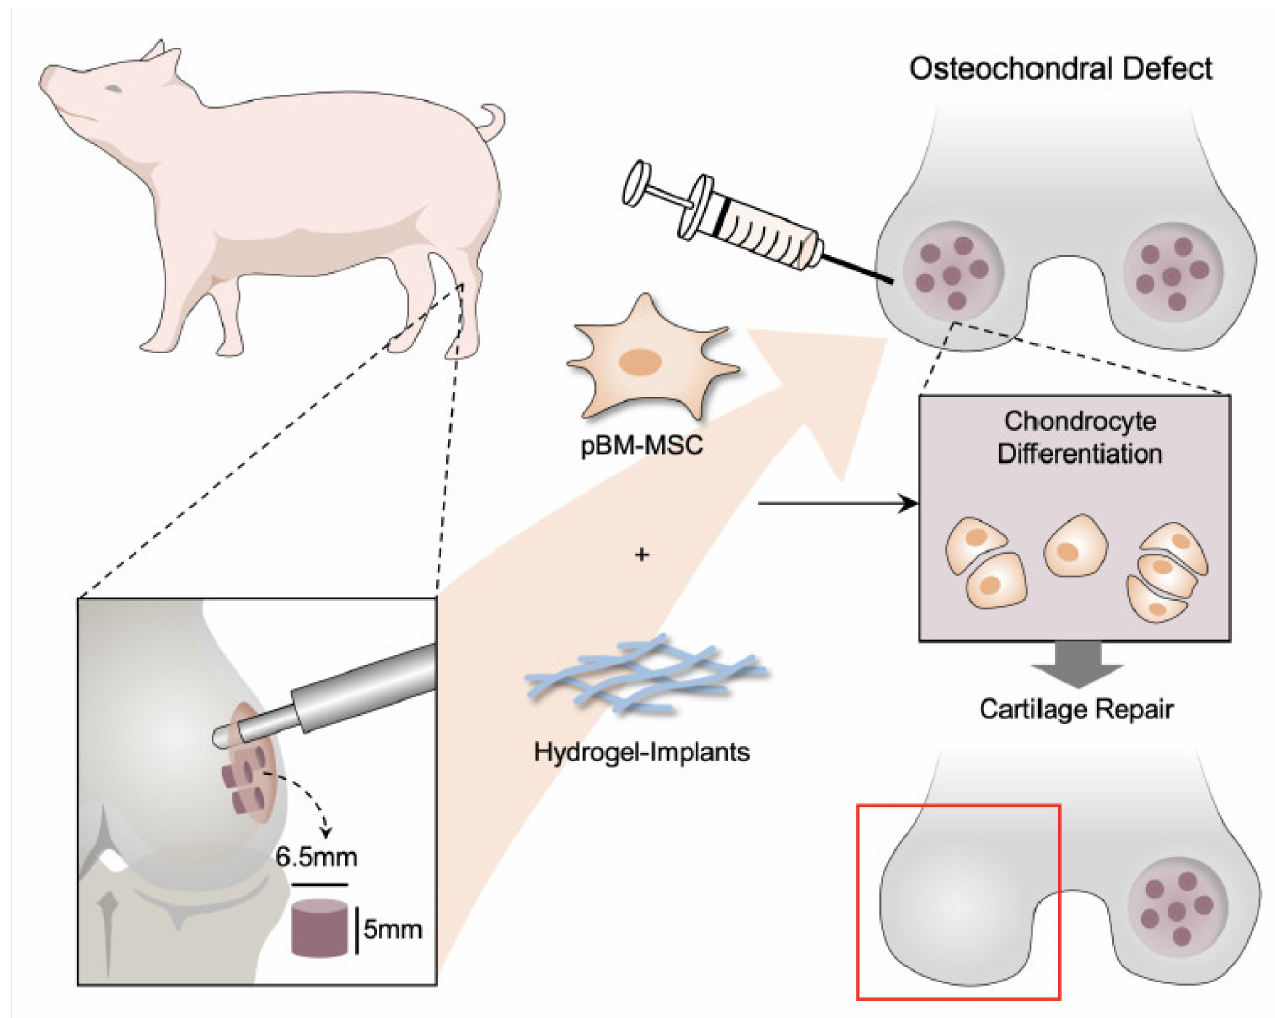
Figure 6. Action of pMSC-based therapies in cartilage regeneration in porcine OCD model. Schematic illustrations of the tissue engineering approach for cartilage repair. In this study, pMSCs were applied as cell replacement therapy because of its chondrogenic differentiation potential.